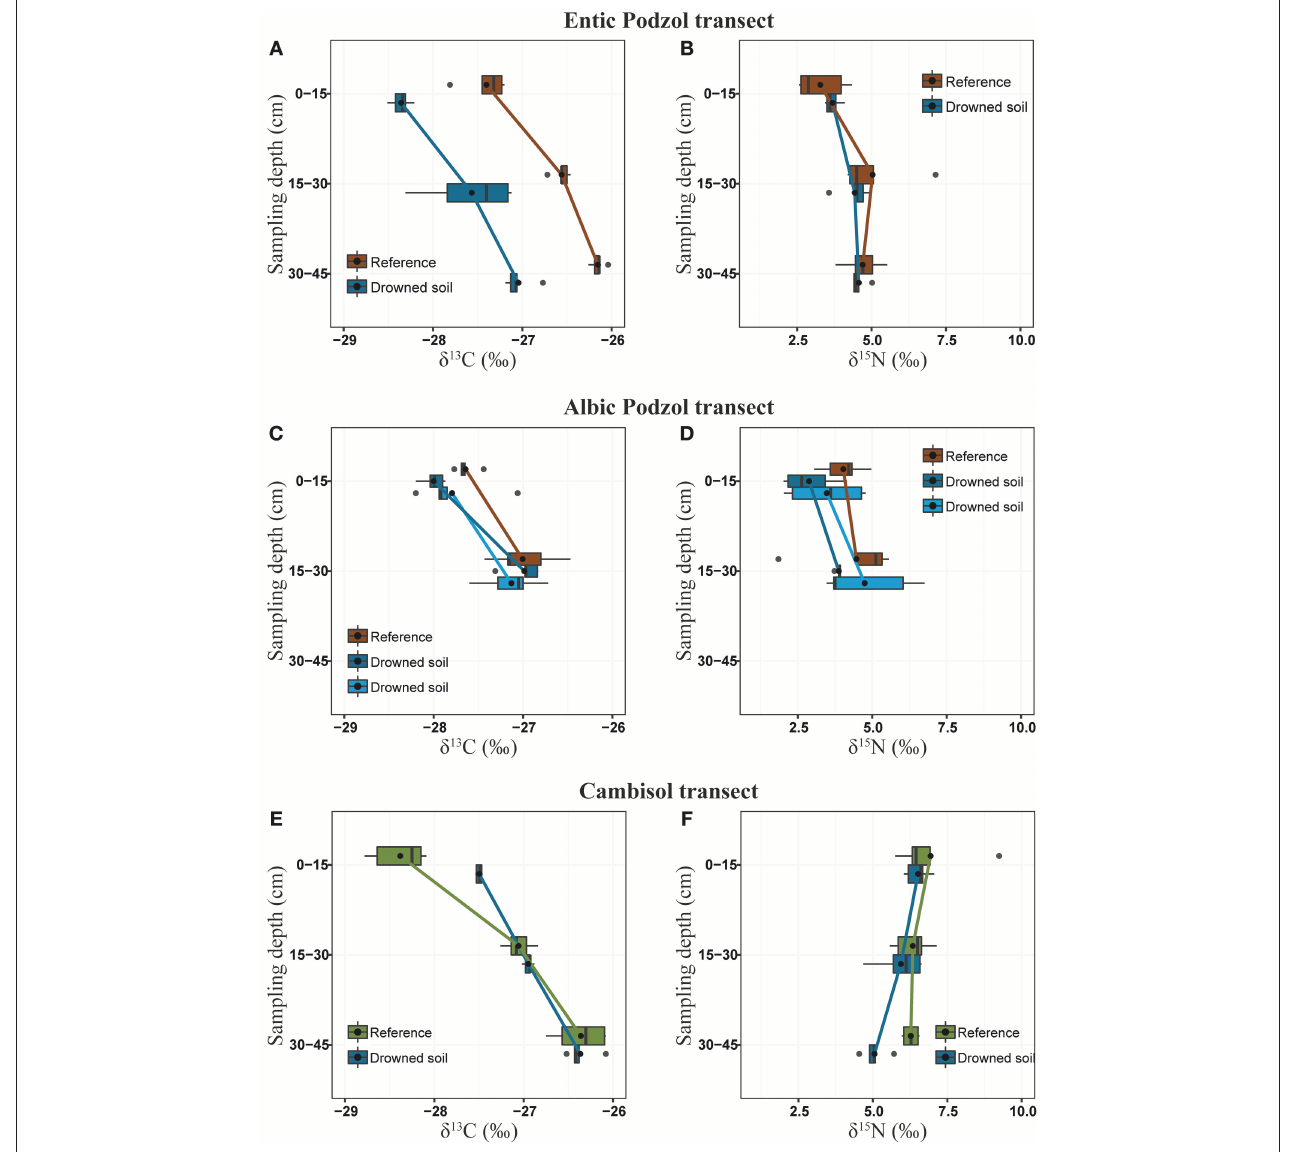
FIGURE 4 | Boxplot of the isotopic ratios ( δ 13 C and δ 15 N) of soil sections. (A,B) Entic Podzol transect. (C,D) Albic Podzol transect. (E,F) Cambisol transect. At each depth, gray dots are outliers and black dots are averages; data for the same soil are connected by lines.